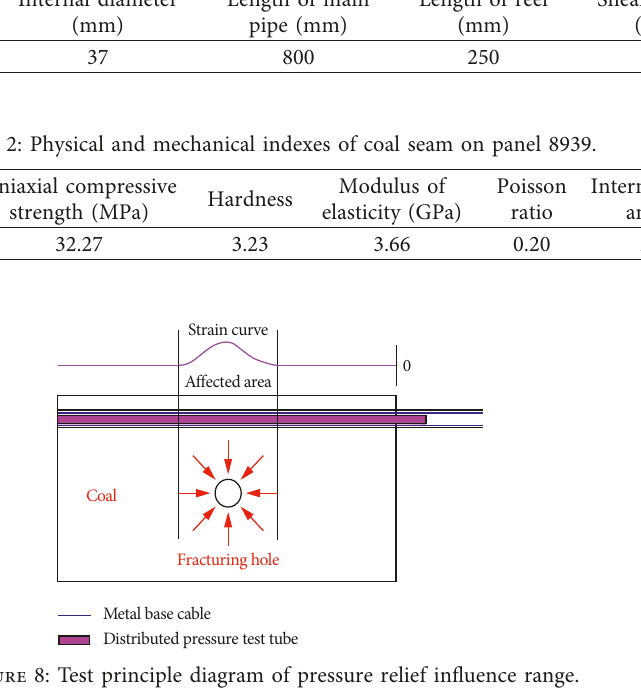
2 fracturing instrument.